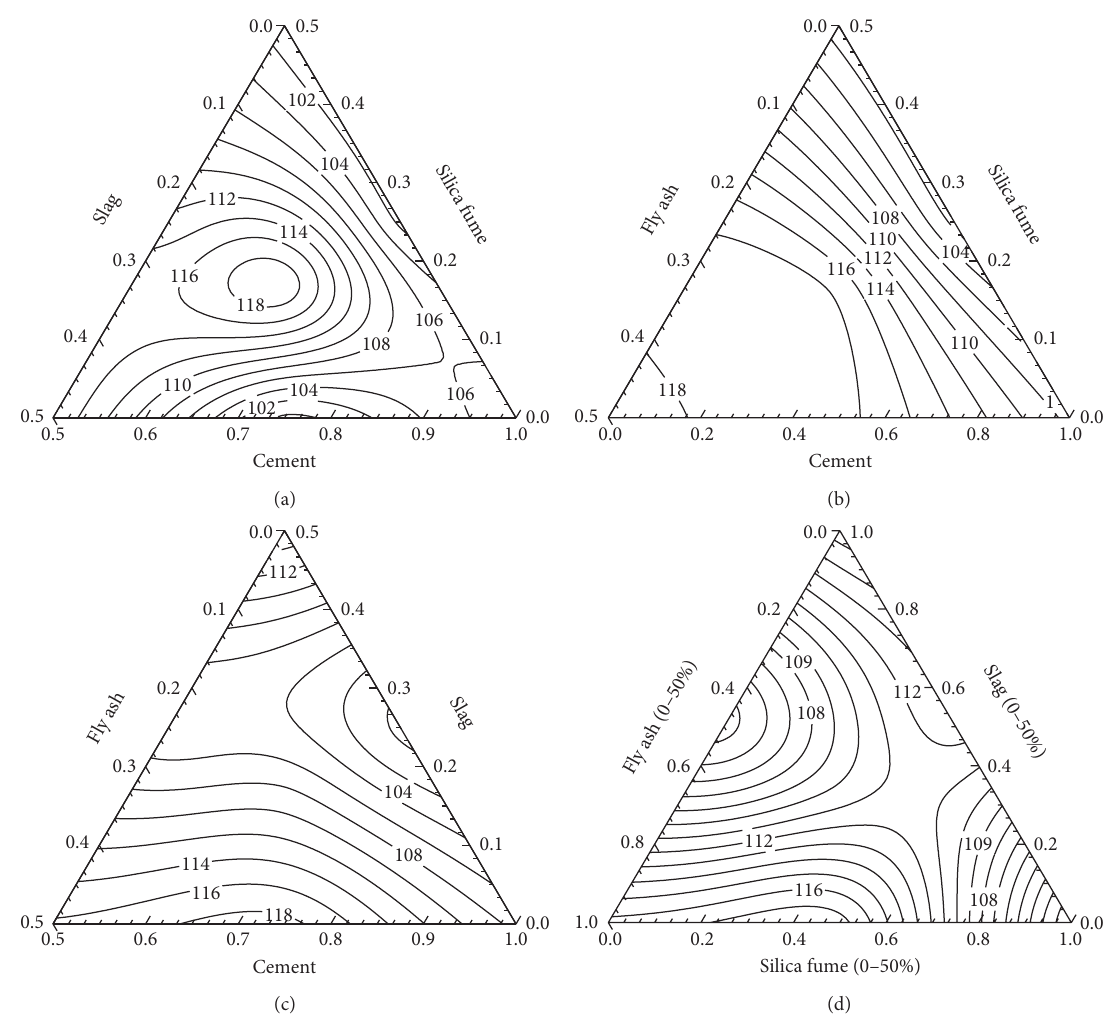
Figure 6: Compressive strength of UHPC (28d) with cementitious system of cement-silica fume-slag-fly ash